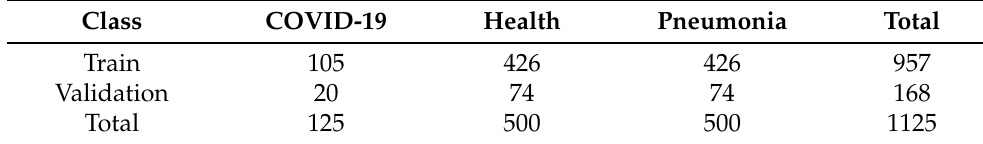
Table 2. Arrangement of the X-ray Image dataset.